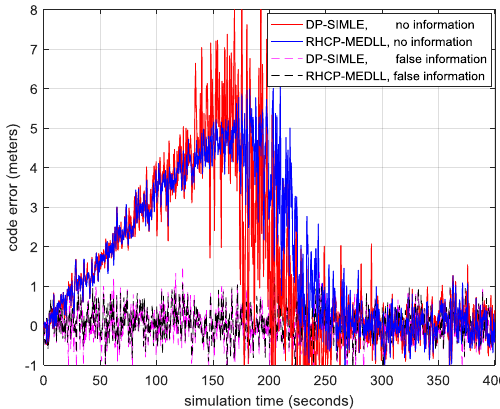
Figure 12. The residual multipath error of DP-SIMLE in some critical cases when the LHCP channel provides invalid information.